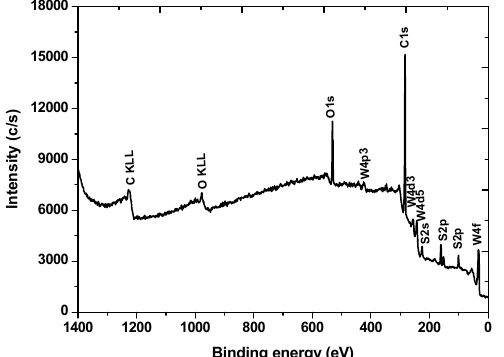
5 of 13 Figure 2. X-ray diffraction pattern of WS 2 nanoflowers. The peak at 29.5° (denoted by *) was assigned to WO 3 . XPS studies provided detailed composition of the nanoflowers. The W and S peaks are clearly displayed on the survey spectrum, shown in Figure 3. Partial oxidation of WS 2 to WO 3 was confirmed by the presence of the O 1s peak. The oxygen peak is also attributed